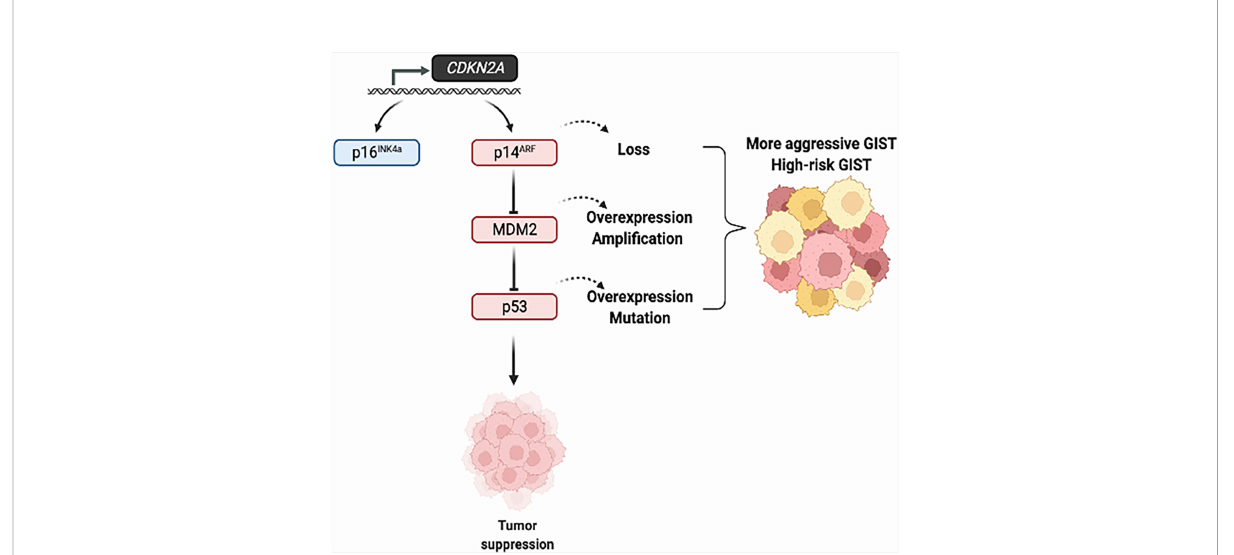
FIGURE 2 Alterations of the CDKN2A/MDM2/p53 pathway in GIST tumors. The tumor suppression function of p53 is regulated by MDM2 and p14ARF. The overexpression of MDM2 and loss of p16 INK4a /p14 ARF , which in turn in fl uence p53 function, lead to tumor progression in